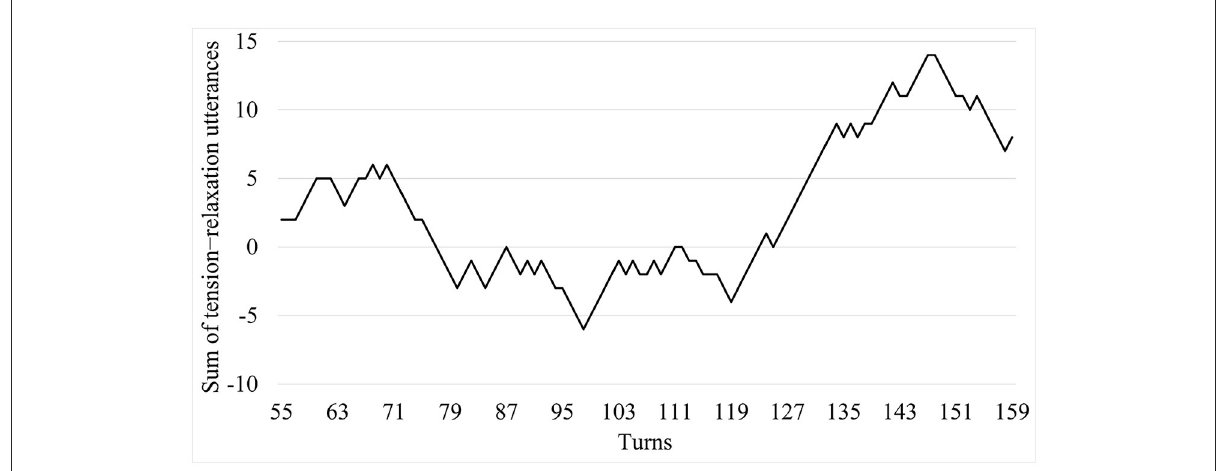
FIGURE3 The pattern of socio-cognitive tension-relaxation during the